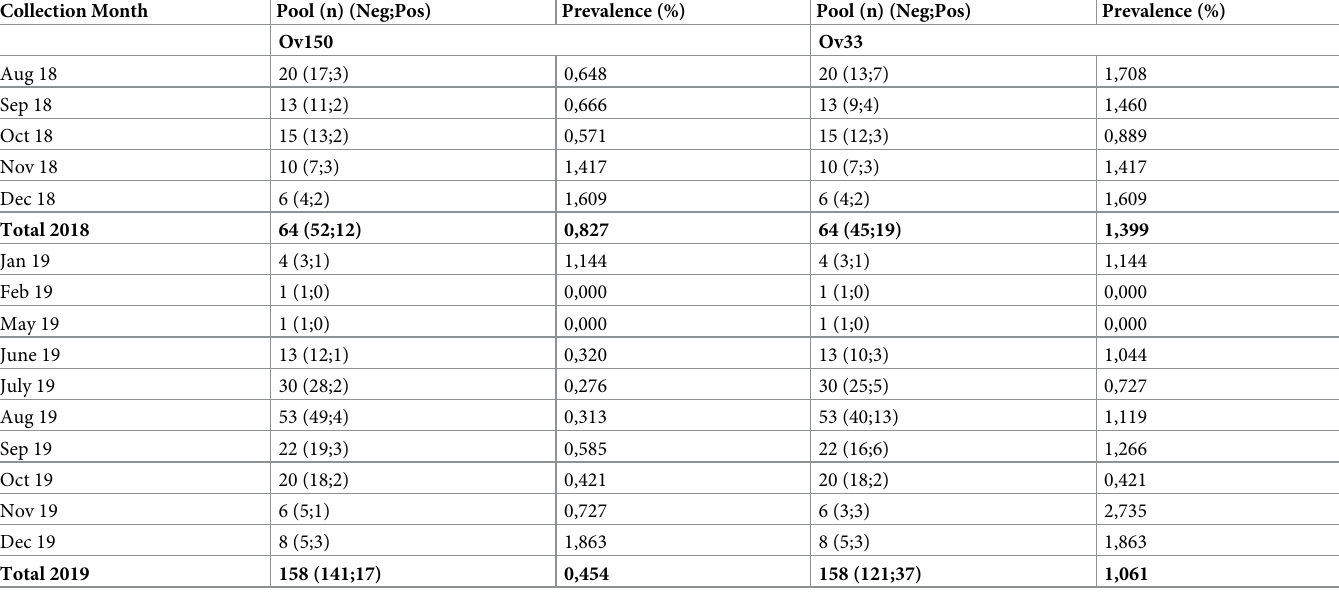
Fig 4. Simulium damnosum s . l . collection. At specific catch points at river Moˆ, in proximity to the village Bouzalo, the collection of S . damnosum s . l . was performed weekly by trained fly catchers from April 2018 until February 2020. Bouzalo village is situated less than 2 km from the Moˆ river. Collections took place from 7am to 6pm alternating the fly catchers every two hours. This long-term collection was to determine the annual biting rate (ABR), which was calculated by multiplying the average number of blackflies caught daily by the number of days per week in the month to add up to 12 months. https://doi.org/10.1371/journal.pntd.0010340.g004 Togo. In chronic filarial diseases, specific IgG4 antibodies make up to 95% of the IgG response [25], requiring repeated antigen stimulation [26], and production of IgG4 is favoured by the cytokines IL-4, IL-13 and IL-10 released by Th2- and Treg-cells. 12yPT all patients were mf- Table 6. Number of Simulium damnosum s . l . pools analysed by qPCR in year 2018 and 2019 for the presence of O . volvulus specific Ov33 and Ov150 DNA. Black- flies were grouped into pools of 25 and the number of Ov33 or OV150 negative and positive pools is